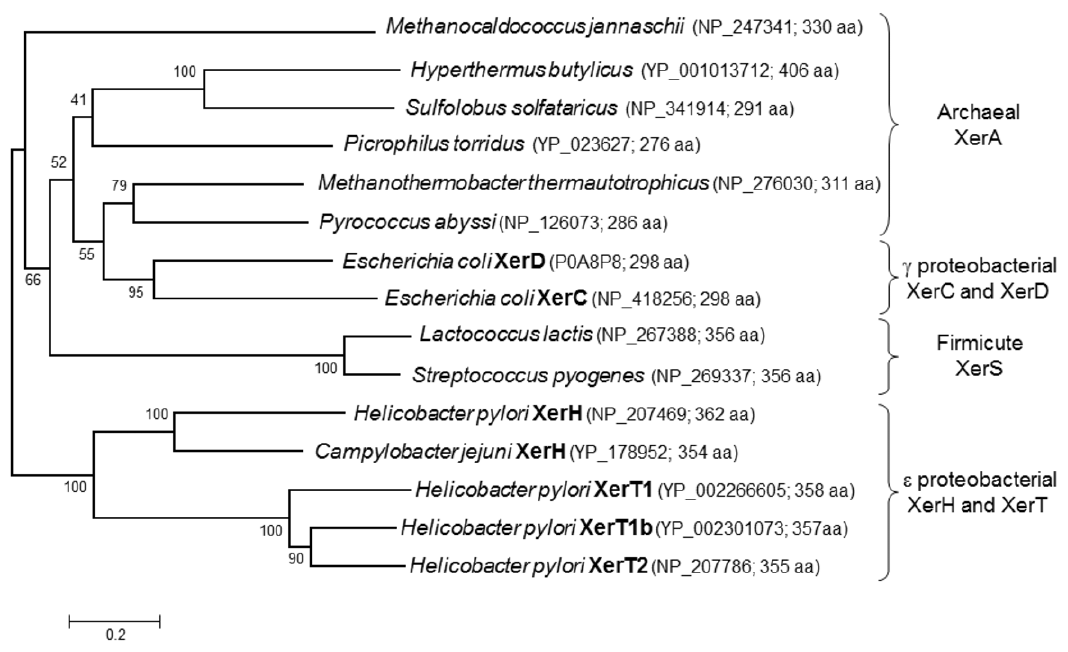
Figure 9. Phylogeny of archaeal and bacterial single-Xer recombinases. Species are representative of their respective taxonomic groups. XerC and XerD from E. coli and XerT from H. pylori were included in the study as reference. Amino acid sequence alignments were performed using Clustal W. The phylogenetic analyses, using the Neighbour-Joining method [34] were conducted in MEGA4 [33]. The percentage of replicate trees in which the associated taxa clustered together in the bootstrap test (1000 replicates) is shown next to the branches. The bootstrap consensus tree is taken to represent the evolutionary history of the taxa analysed. For each species, the accession number is indicated as well as the number of amino acid residues composing the